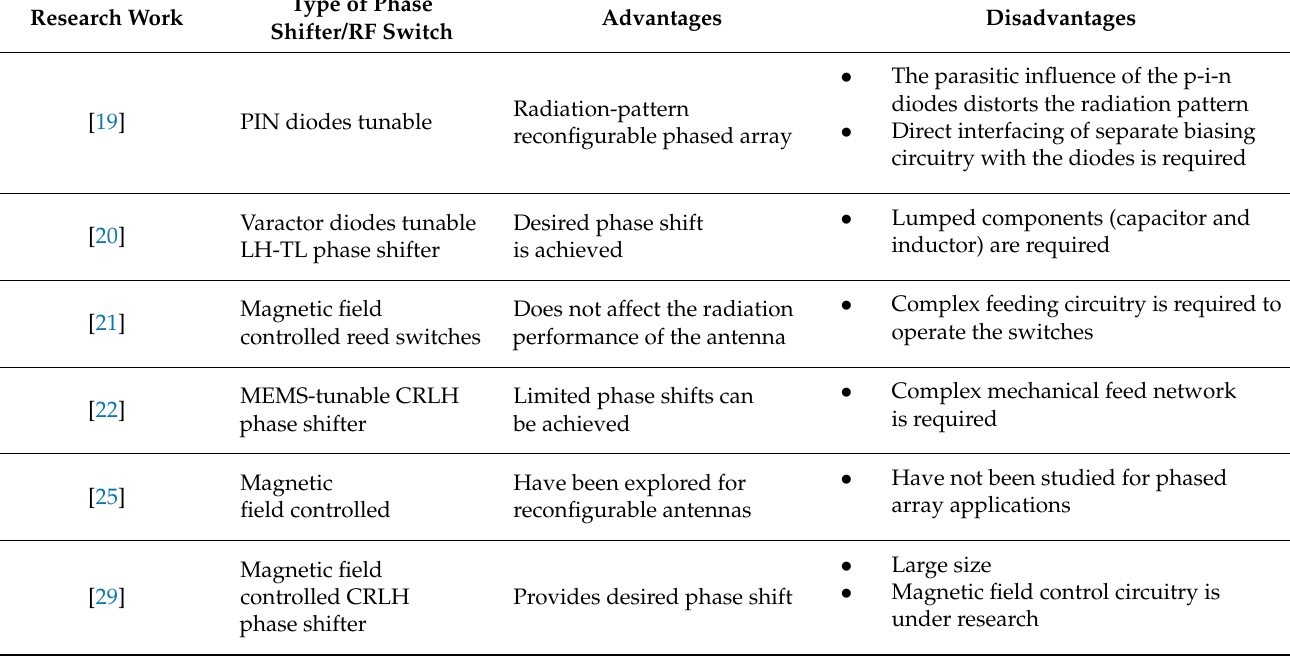
Table 2. Qualitative comparison of the proposed work with selected existing